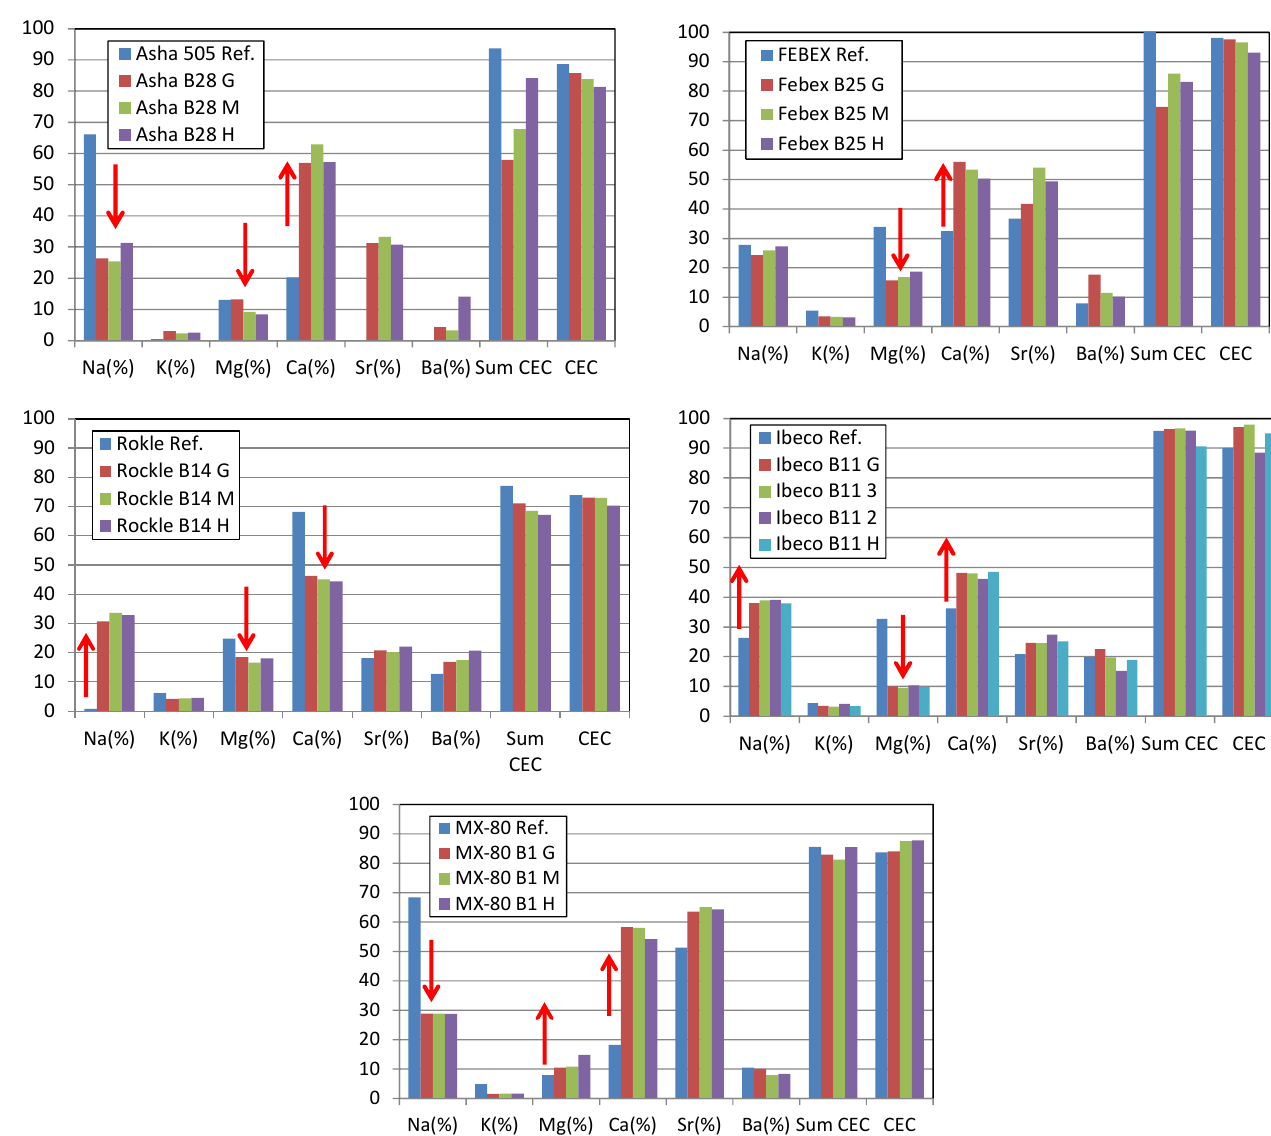
Figure 14. Cation exchange population after dismantling of the ABM5 experiment. Sr and Ba percentage is multiplied by 100 and 1000, respectively. Arrows: variations of content ( ↑ : increases or decreases).